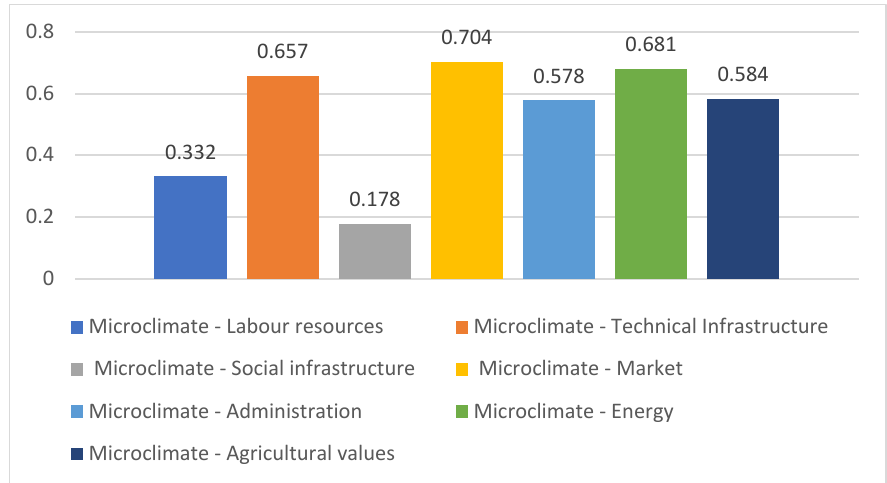
Figure 2. Correlation coefficient between individual microclimates and the aggregated potential investment attractiveness index at the local level (PAI A LOCAL) in Poland. Source: own research. In the eighth step, the statistical units were classified into investment attractiveness basis for the division of spatial units into classes A–F, where class A stands for the